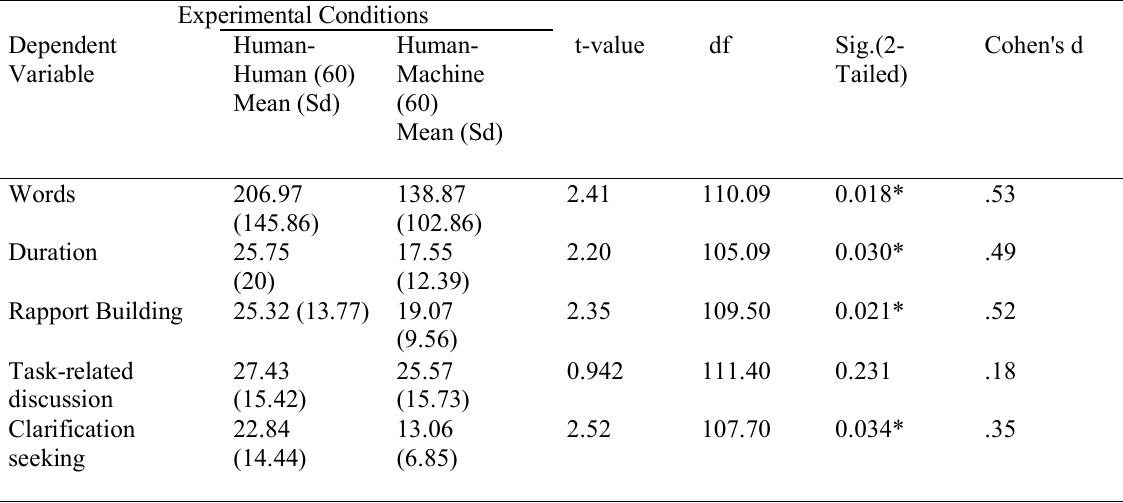
Table 2 . Independent sample t-test analysis of communication